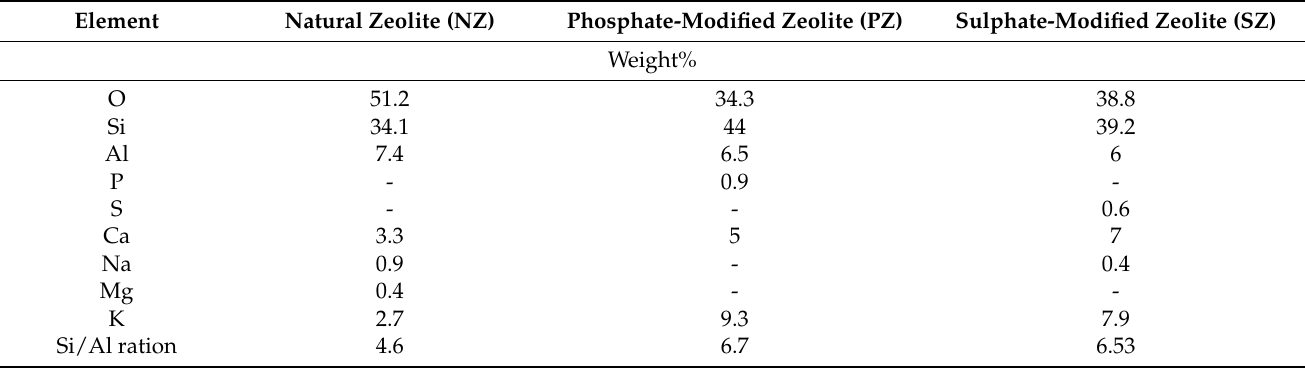
Table 4. EDX analysis showing the elemental composition for NZ, PZ, and SZ.